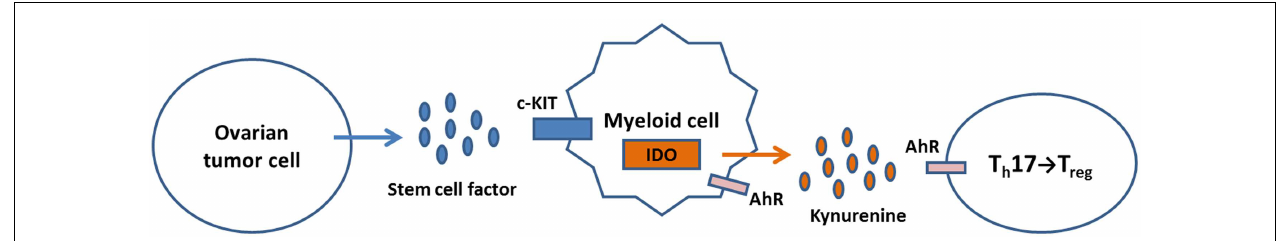
The tryptophan catabolite kynurenine binds AhR onT cells, which shifts the Th17/Treg balance in favor ofTreg generation. Kynurenine can also bind AhR on myeloid cells, further inducing IDO expression through a feedback